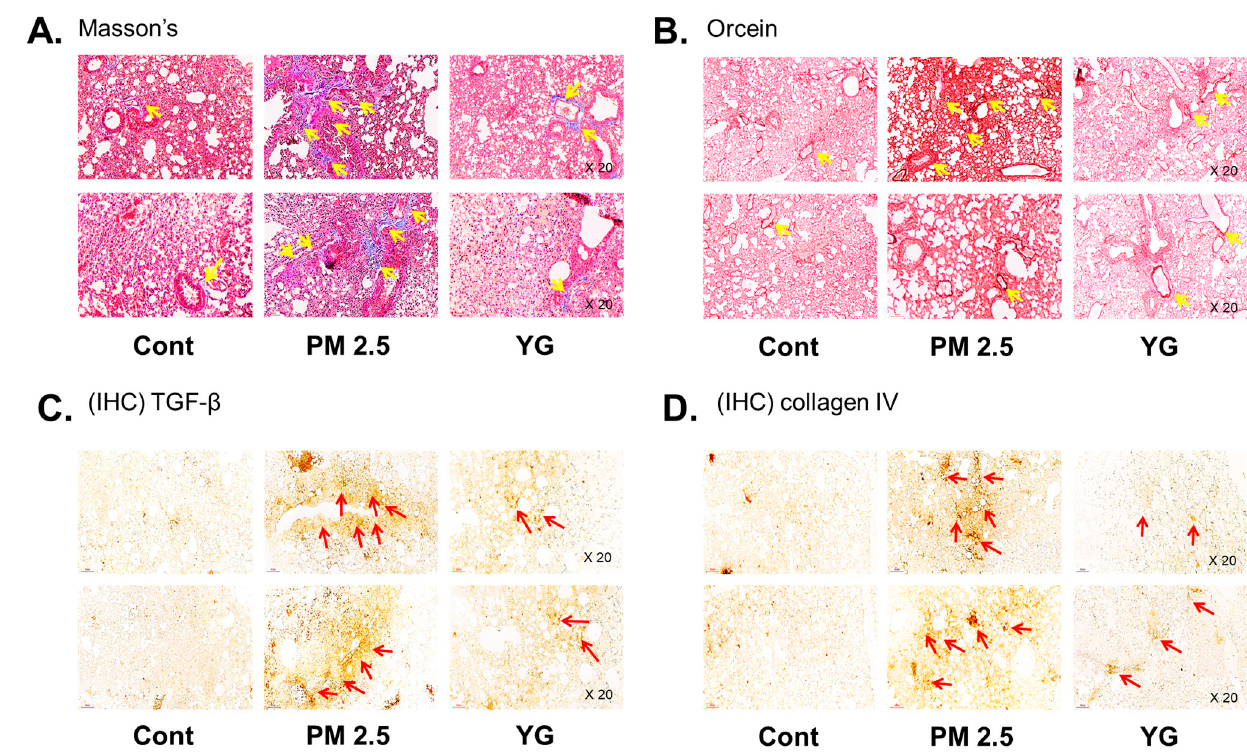
Figure 6. The effect of YG-1 extract treatment on lung injury in fine particulate matter (PM2.5)-stimulated mice was histologically confirmed. To confirm that YG extract treatment inhibited fibrosis of the PM2.5 stimulated mice, histological changes were observed by masson’s trichrome (collagen fibers, A ) and orcein (elastic fibers, B ) staining in bronchial tissues. IHC staining was performed to examine the expression of TGF- β ( C ) and collagen IV ( D ) in lung tissues. Yellow arrows indicate the location of collagen fibers ( A ) and elastic fibers ( B ). Red arrows indicated where TGF-b ( C ) and collagen ( D ) were expressed by immunohistochemistry. Histopathological lesions and changes were assessed by histological analyses by optical microscope (magnification, ×200; ( n = 3~4 for each group). Cont, control; PM2.5, PM2.5 exposure mice; YG-1, PM2.5 exposure mice + YG-1 treated (200 mg/kg/daily, orally); Massnon’s, masson’s trichrome staining; Orcein, orcein staining; IHC, Immunohistochemistry staining; TGF- β , transforming growth factor- β .